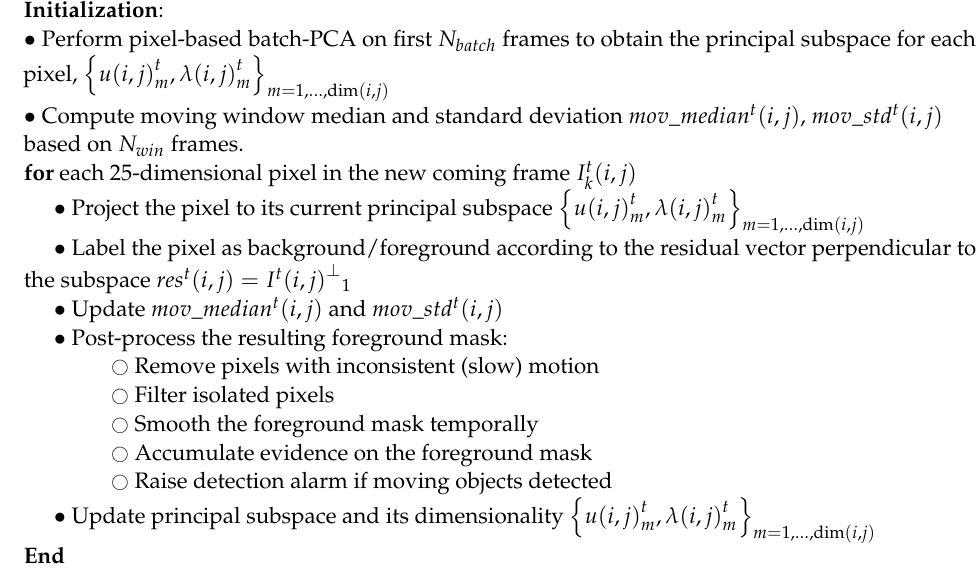
Algorithm 1: Hyperspectral Background